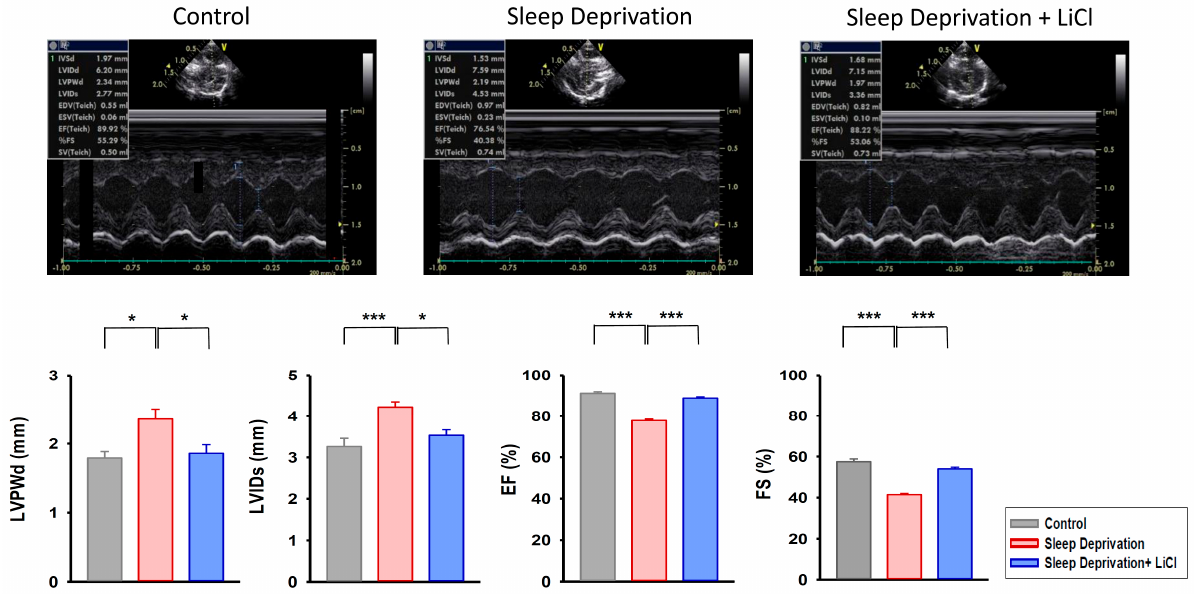
Figure 1. Echocardiographic study in REM sleep deprivation with and without lithium treatment. The REM sleep-deprived rats ( n = 8) had increased left ventricular posterior wall thickness at end-diastole (LVPWd) and increased internal diameter at end-systole (LVIDs) compared with the control rats ( n = 8) and lithium-treated REM sleep-deprived rats ( n = 8). In addition, the REM sleep-deprived rats exhibited a lower left ventricular ejection fraction (EF) and lower fractional shortening (FS) compared with the control and lithium-treated REM sleep-deprived rats. * p < 0.05; *** p < 0.001.